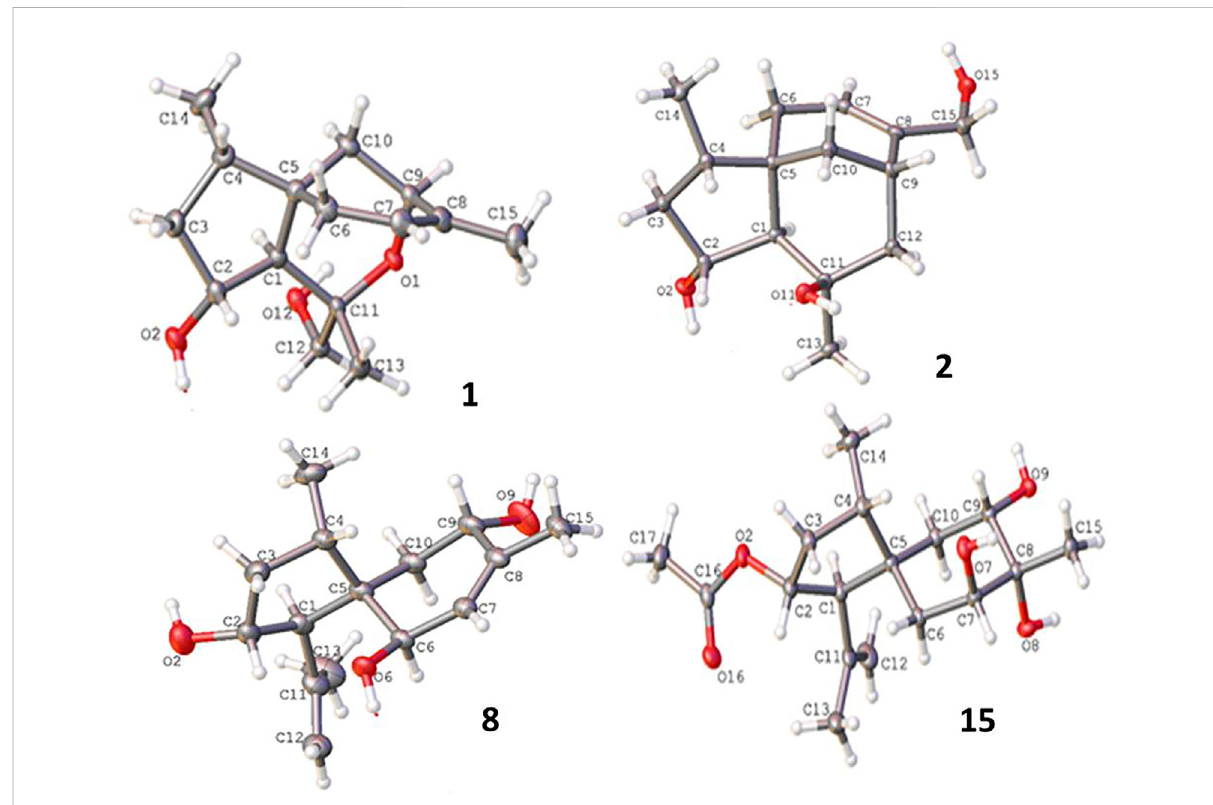
FIGURE 5 Structures of X-ray diffractions of 1 – 2 , 8 , and 15